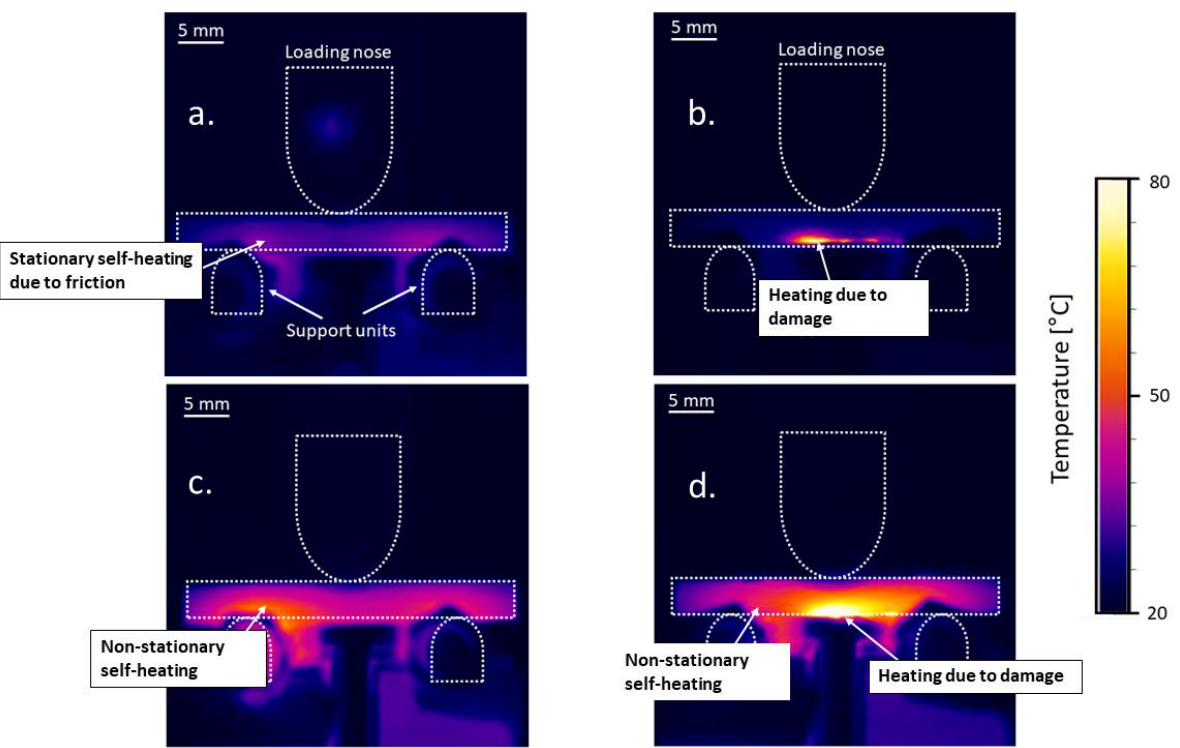
Figure 10. The characteristic features observed during the ultrasonic fatigue loading of VHCF specimens tested at different cyclic amplitudes and pause times: ( a ) stationary self−heating due to friction between the specimen and support units; ( b ) heating in the presence of damage; ( c ) non−stationary self-heating; ( d ) combination of non-stationary self−heating and damage.